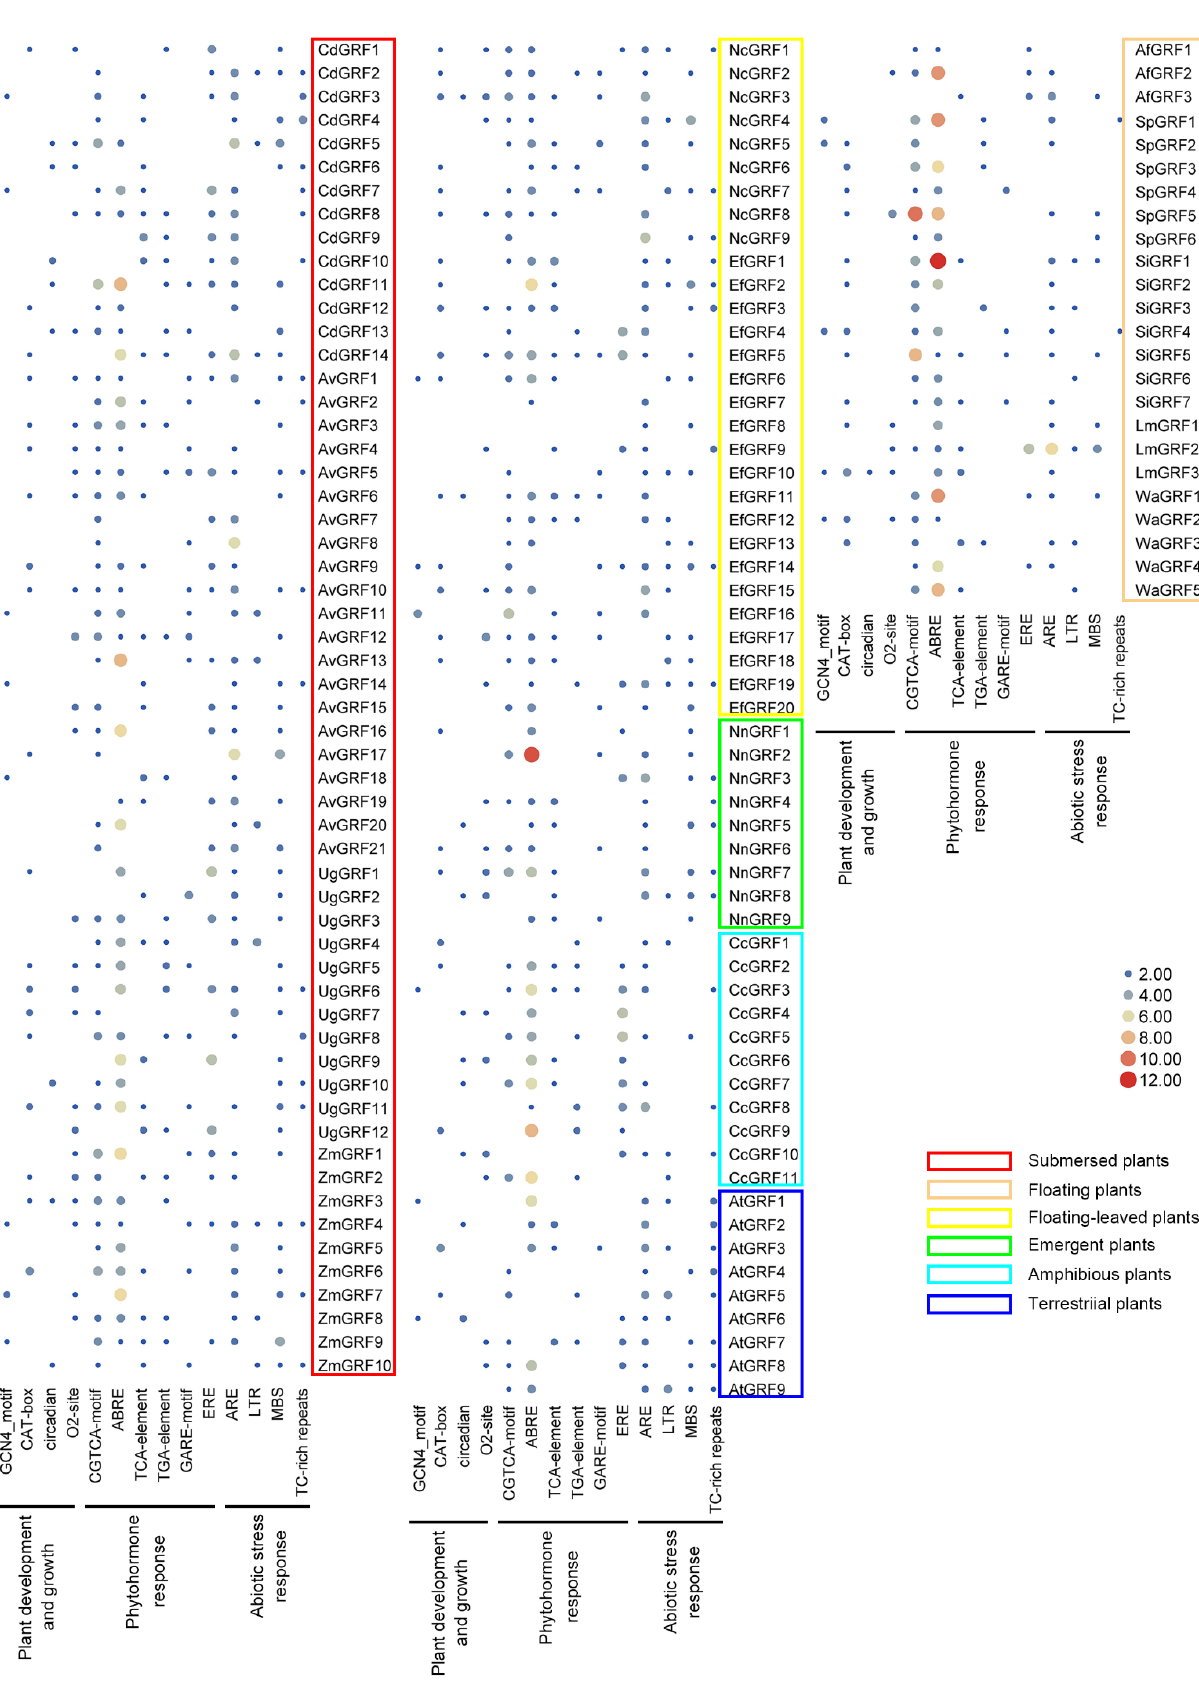
Figure 5. Frequency of the main cis-elements in the 1.5 kb promoter of the 139 GRFs .